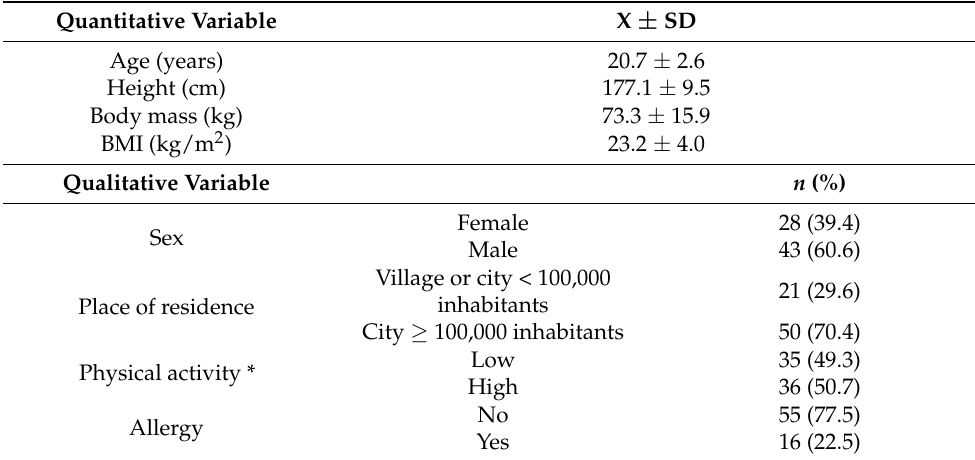
Table 1. Anthropometric variables, physical activity patterns, and allergy status of the study group ( n = 71).